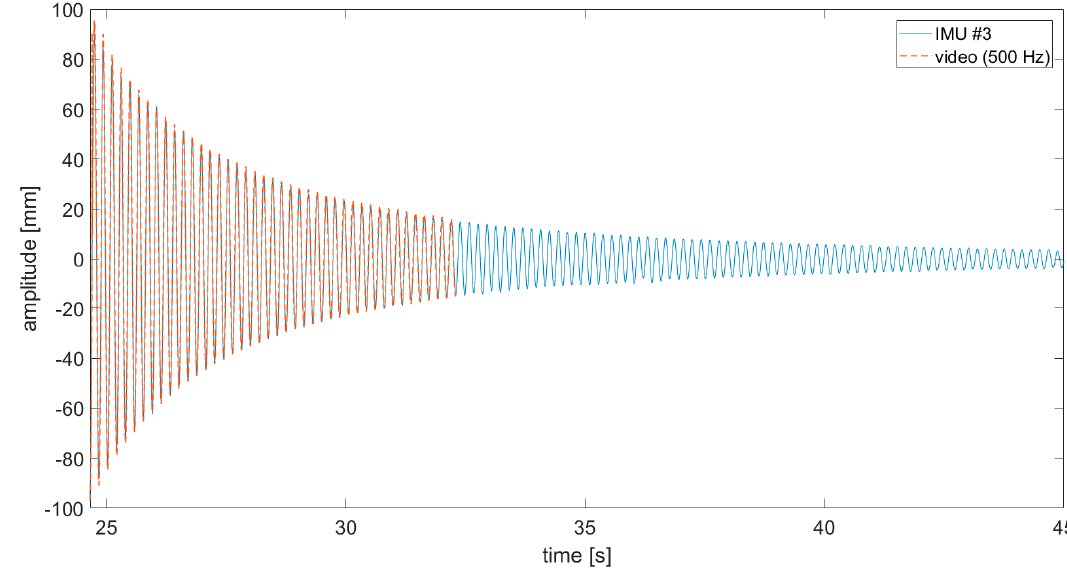
Figure 9. Comparison of displacement time histories (video vs. IMU #3 acquisition).